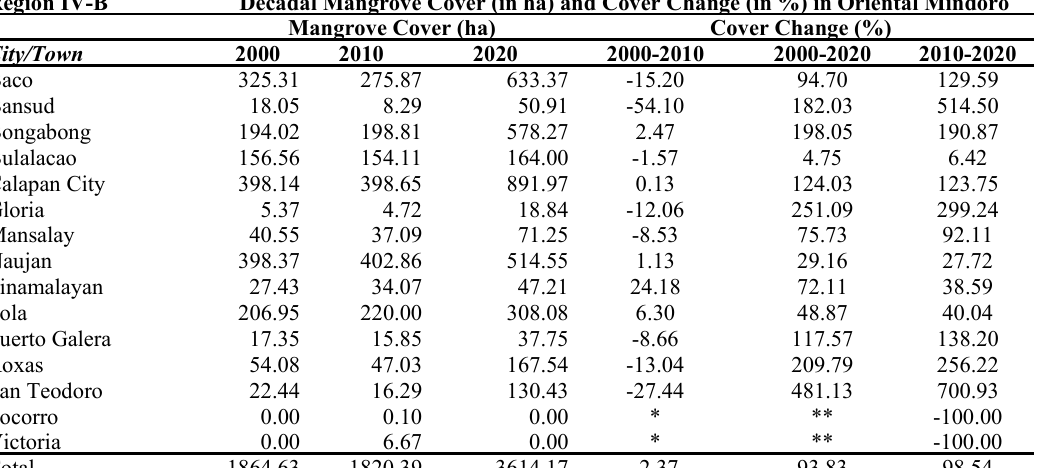
Table 4. Extracted Mangrove area (in ha) estimates in Oriental Mindoro. Note: *percent change from 0 to a value. **percent change from 0 to